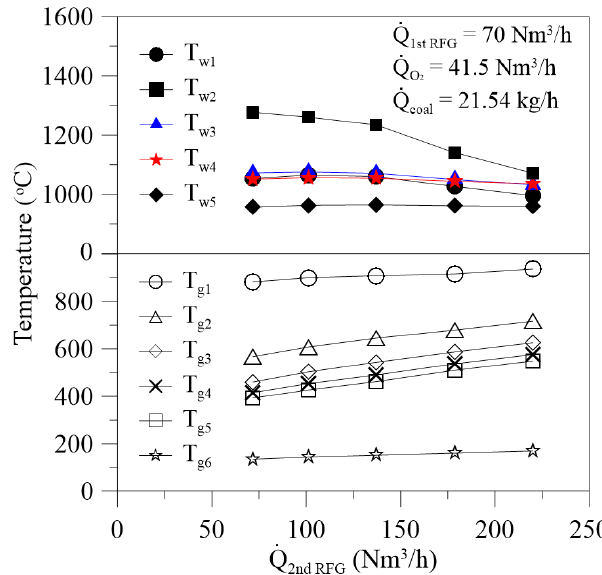
Figure 5. Variations in temperature with the 2nd RFG flow rate for Australian coal under oxy-combustion at Q O2 = 41.5 Nm 3 / h, where Q O2 is the volume flow rate of pure oxygen.